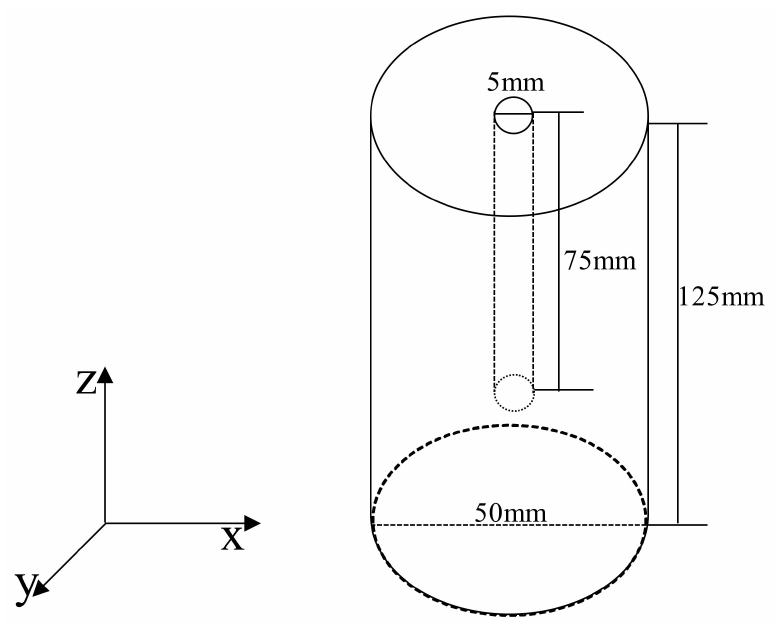
Figure 1. Geometry of the rock sample.